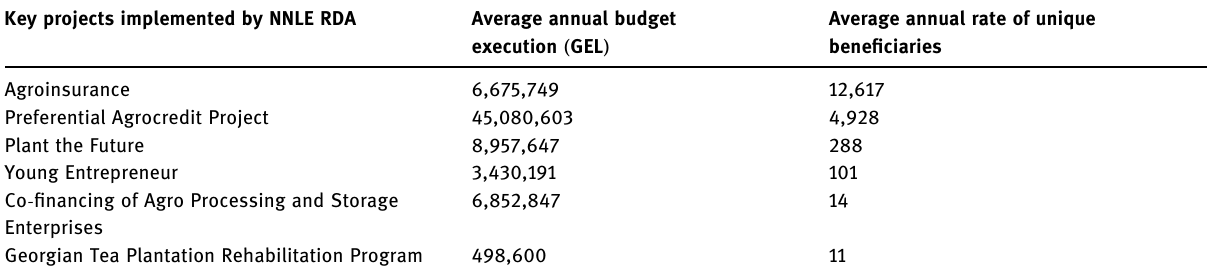
Table 3: Key projects implemented by NNLE Rural Development Agency Key projects implemented by NNLE RDA